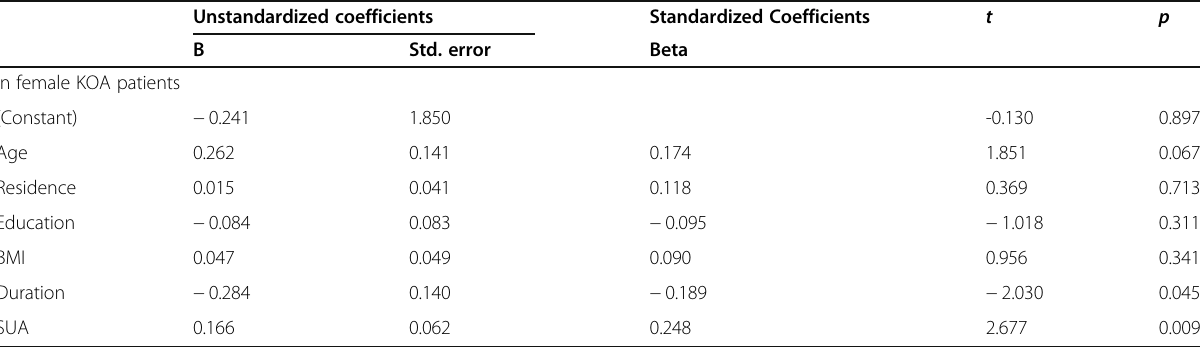
Table 5 Multivariate regression analysis for factors associated with Kellgren-Lawrence grade in female patients with knee